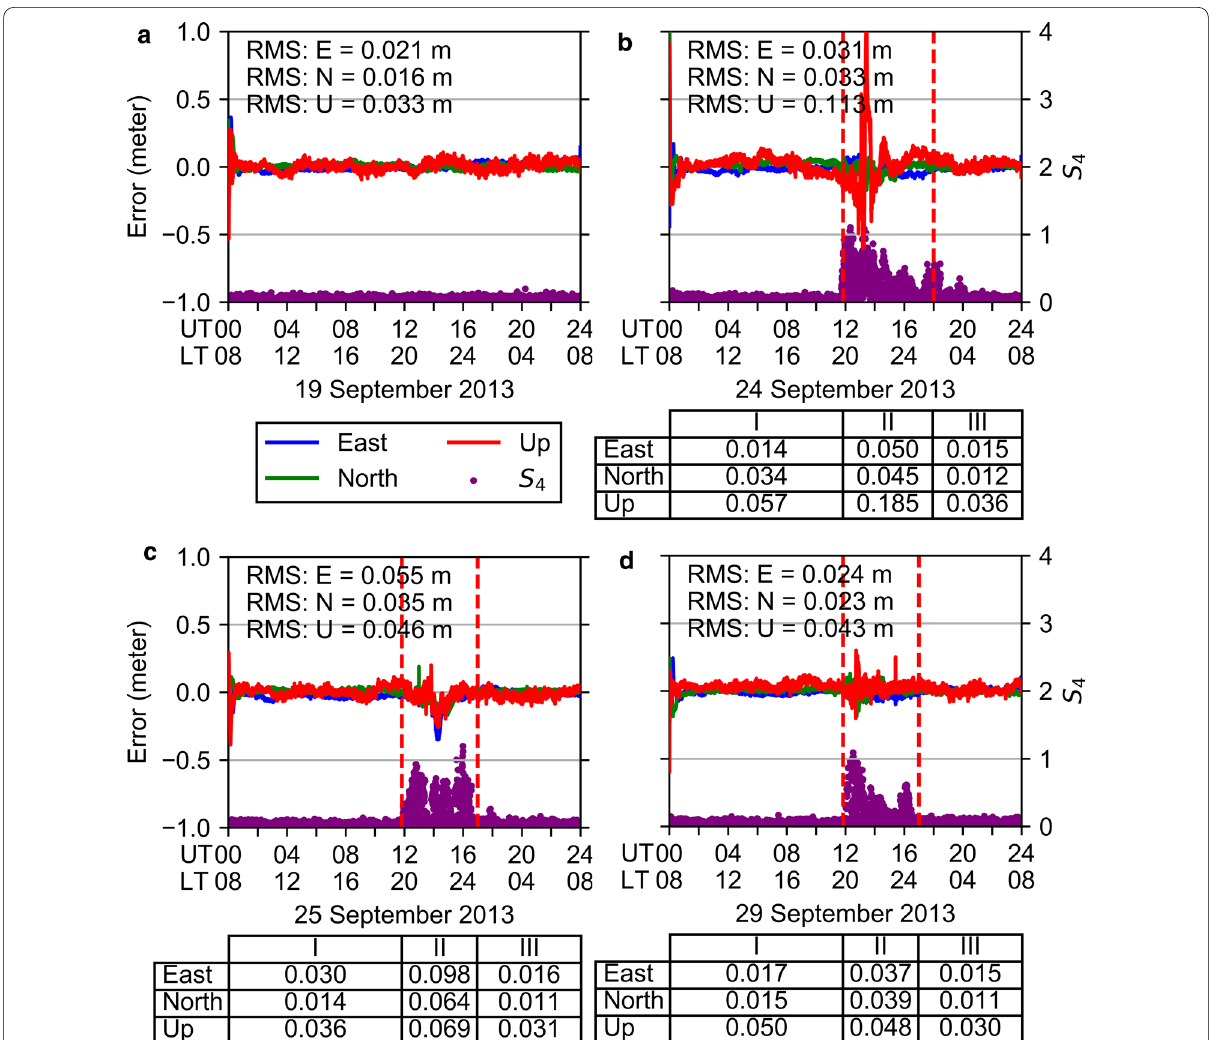
Fig. 10 Positioning errors in the components of east, north, and up along with ionospheric scintillation index at the HKPC station on four typical days: 19 September 2013 ( a ) with no scintillations; 24 ( b ), 25 ( c ), and 29 ( d ) September 2013 with much more scintillations. The RMS of the positioning errors during different periods, as separated by the vertical dashed lines, is presented in the